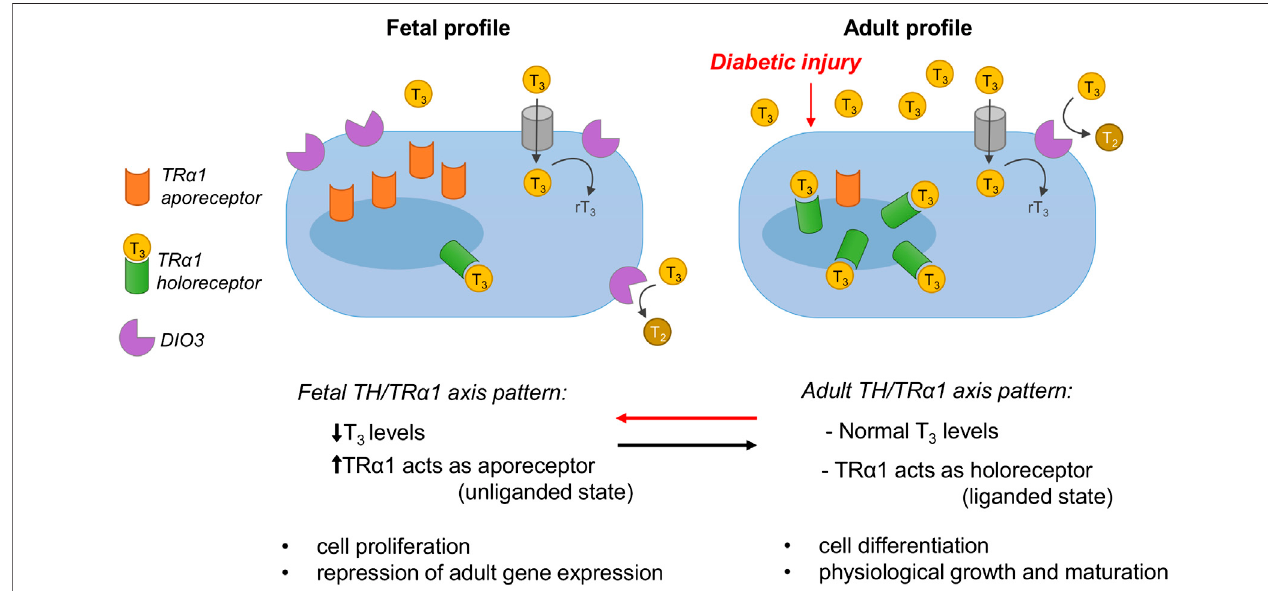
FIGURE 4 | In the fetus, when the levels of the active form of TH L-triiodothyronine (T3) are low, TR α 1 mainly acts as an apo-receptor (unliganded state) to repress adultgenes(thusprotectingtheembryofromprematuredifferentiation) andenhancescellproliferationandorgan growth.Incontrast,afterbirth whenT3levelsincrease, TR α 1 switches to the holo-receptor (liganded state) to induce the expression of adult genes, thus promoting cell differentiation, physiological organ maturation and